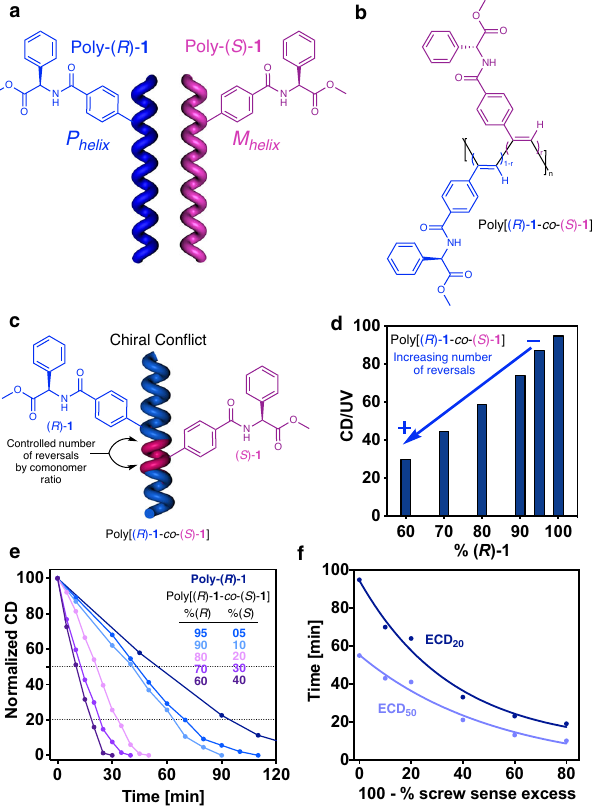
Fig. 4 | Chiral con fl ict phenomenon. a Chemical structure and helix sense representation of poly-( R )- 1 and poly-( S )- 1 . b Chemical structure of the copolymer poly[( R )- 1 -co-( S )- 1 ]. c Conceptual representation of the chiral con fl ict phenom- enon. d Variation of the CD/UV signal (CD@368nm) vs percentage of ( R )- 1 in the poly[( R )- 1 -co-( S )- 1 ] series. e Normalized CD signaldecay (CD@368nm) vs. time for poly[( R )- 1 -co-( S )- 1 ]seriesatdifferentirradiationtimesundervisiblelight(darkblue to purple gradient color palette). f Time consumed for reach ECD signal 50% and 20% during the photochemicalelectrocyclization vs. percentage of reversalsin the poly[( R )- 1 -co-( S )- 1 ] series (light blue and dark blue lines, respectively). [poly[( R )- 1 - co-( S )- 1 ]]= 1.02·10 -3 M.